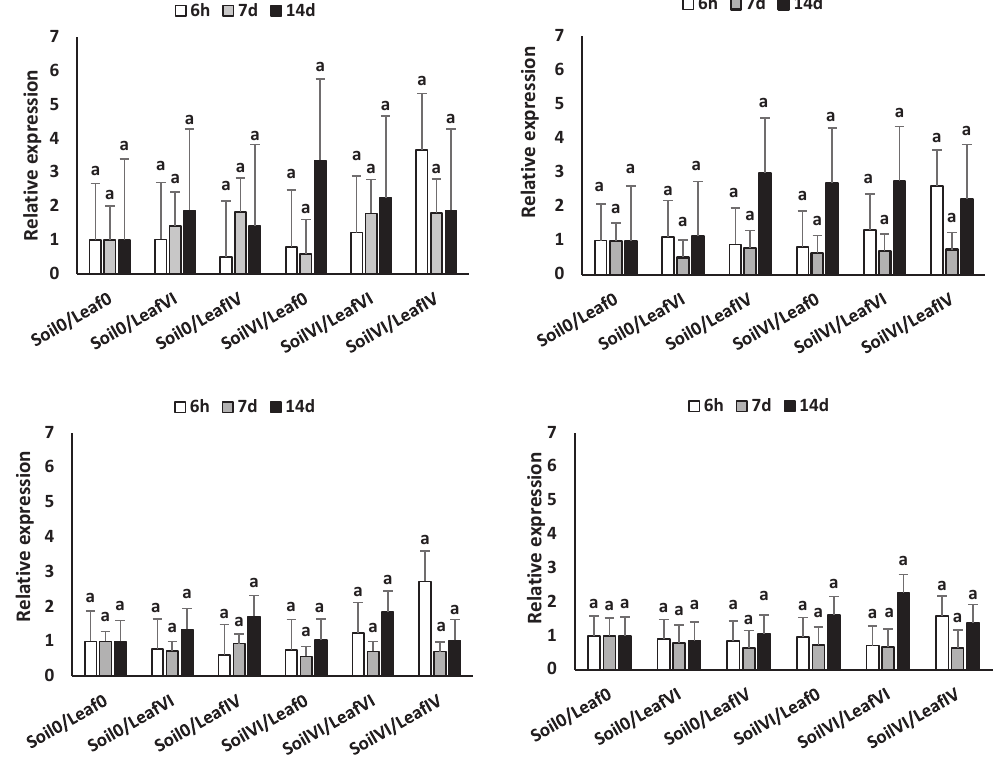
Fig. 1. Relative expression of a) APS1, b) APS2, c) APS3 and d) SMT genes at 6 h (white), 7 d (grey) and 14 d (black) after treatment with 0 or 130 µg Se plant -1 as Na